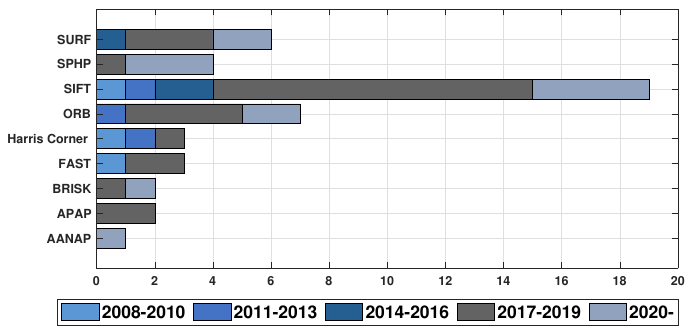
Figure 12. Methodology developments by